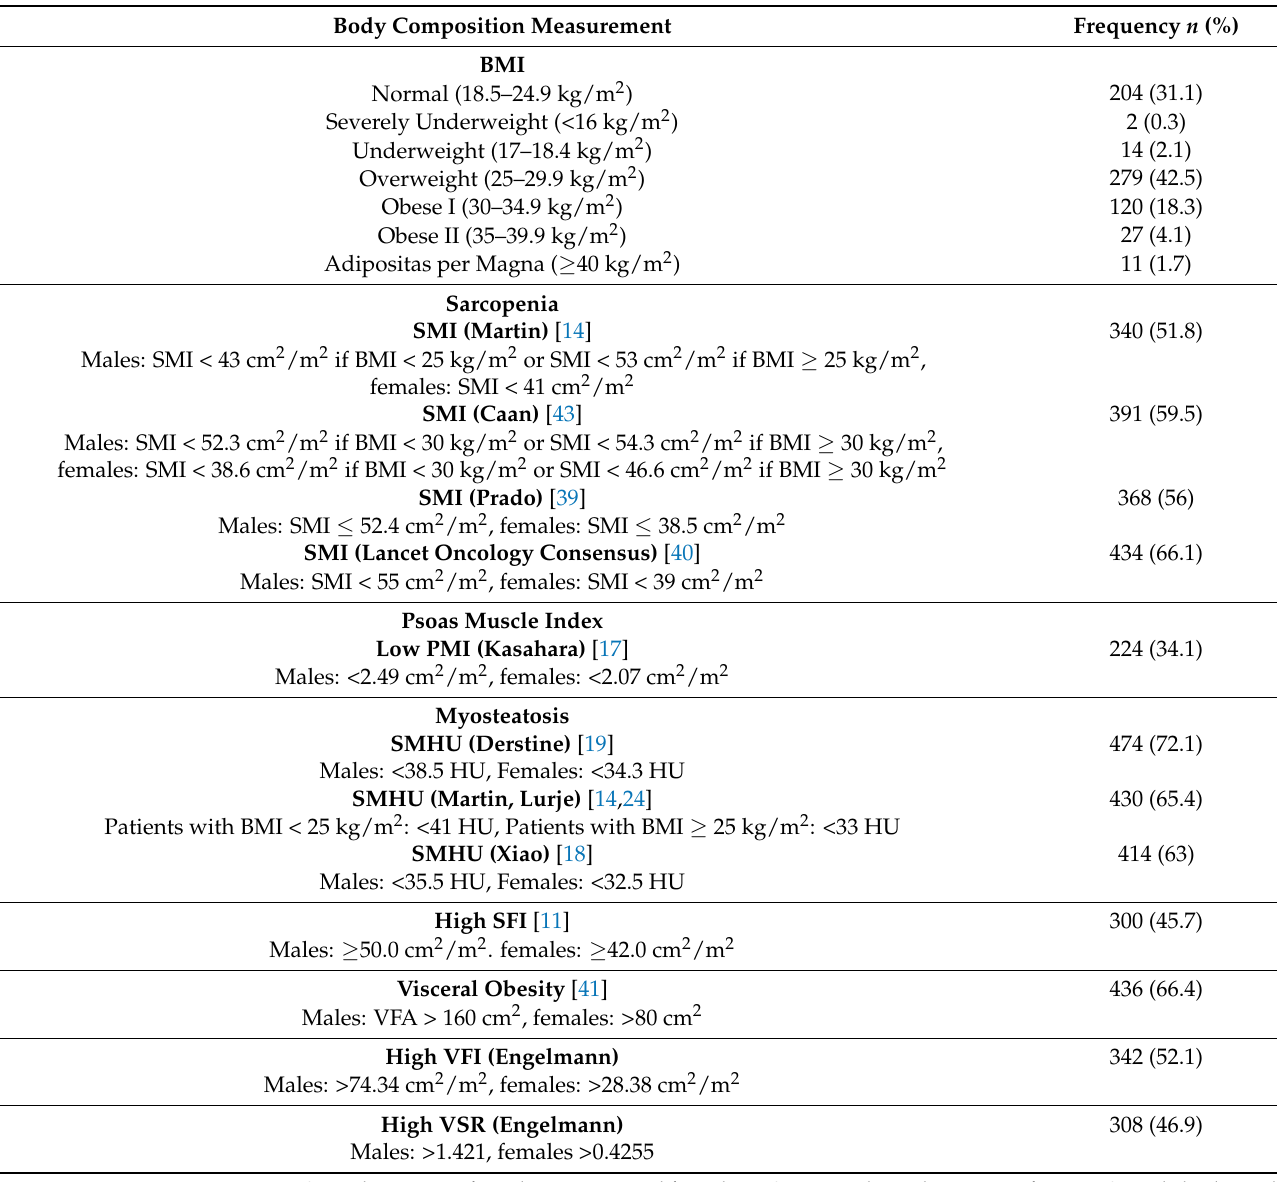
Table 1. Computed tomography-derived body composition measures and thresholds used and calculated for the entire cohort of 657 bladder cancer patients who underwent radical